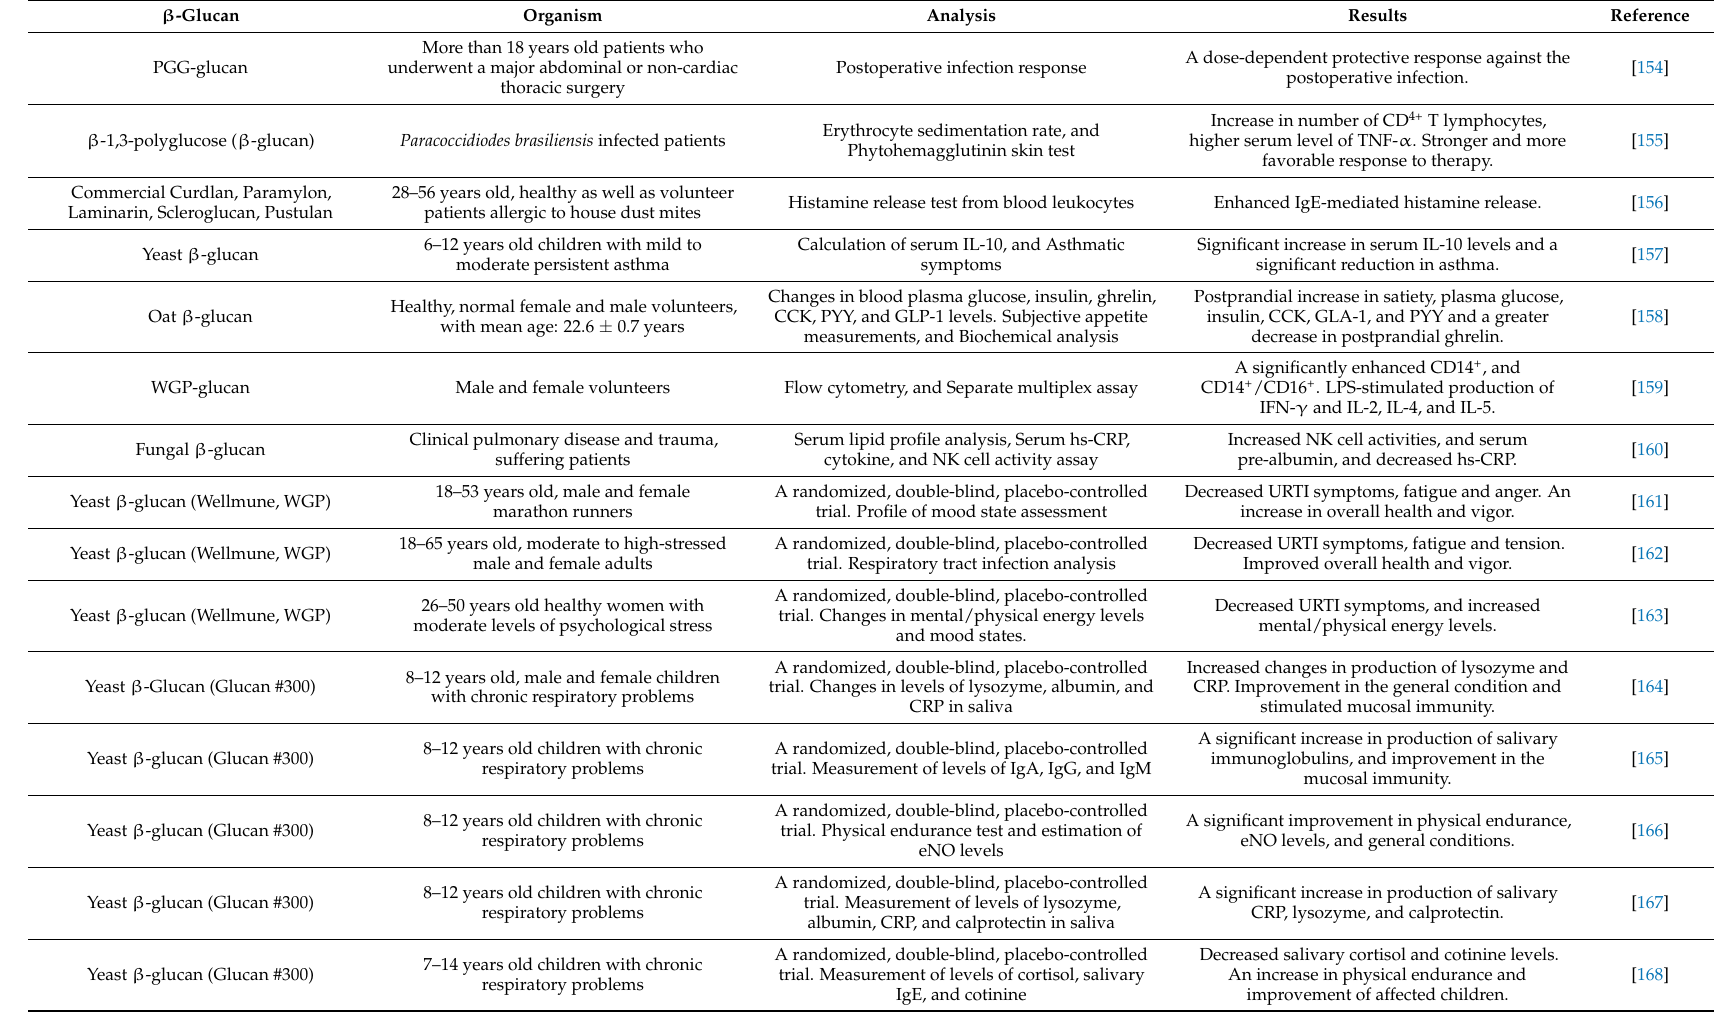
Table 7. Immunomodulating effects of β -glucans—human